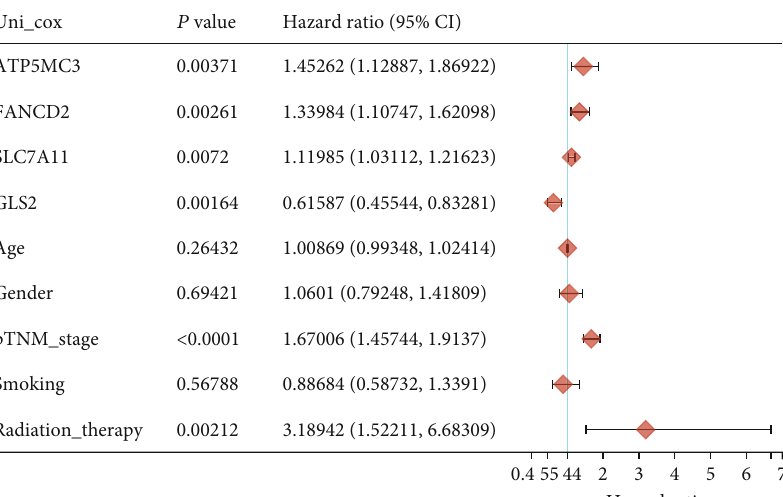
Figure 4: Univariable Cox regressive analyses were completed on all clinical covariates to identify its impact on survival.